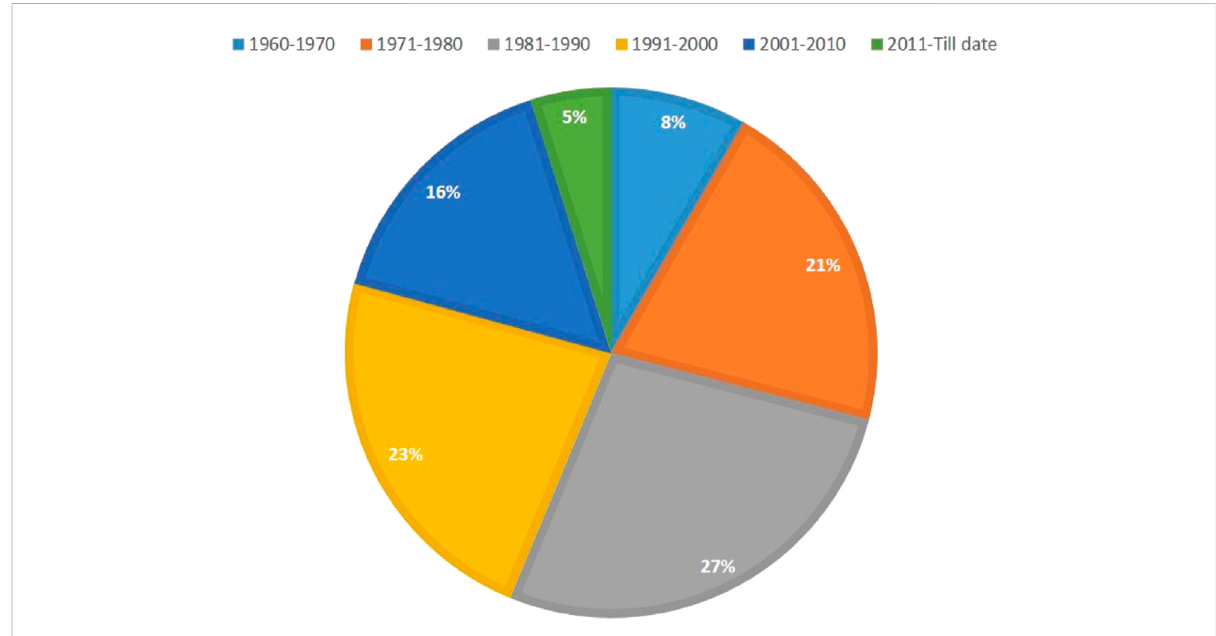
FIGURE 2 Percentage of mutant wheat varieties developed through mutagenesis in various decades (Data source: https://nucleus.iaea.org/sites/mvd/